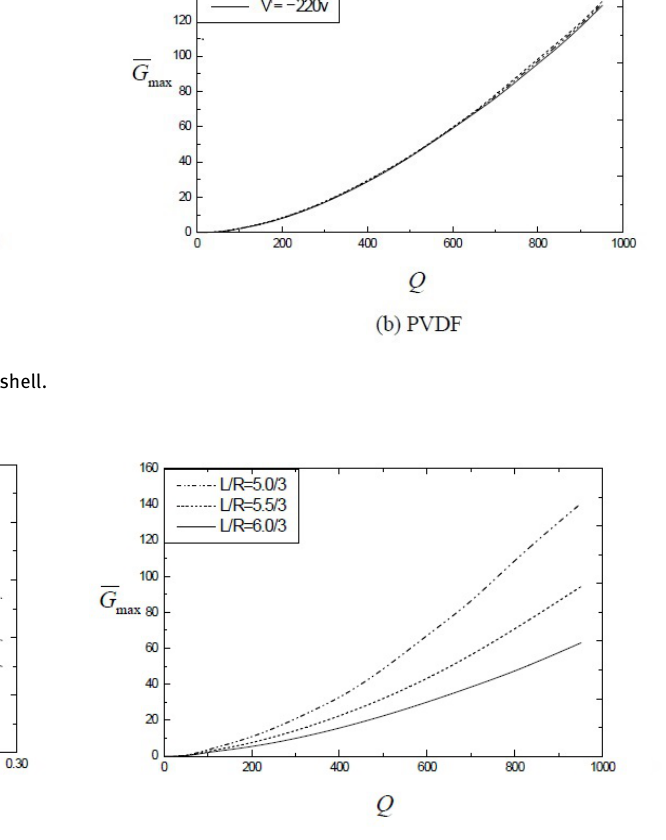
Fig. 9. Effect of the ratio of L / R on maximum of energy release rate.